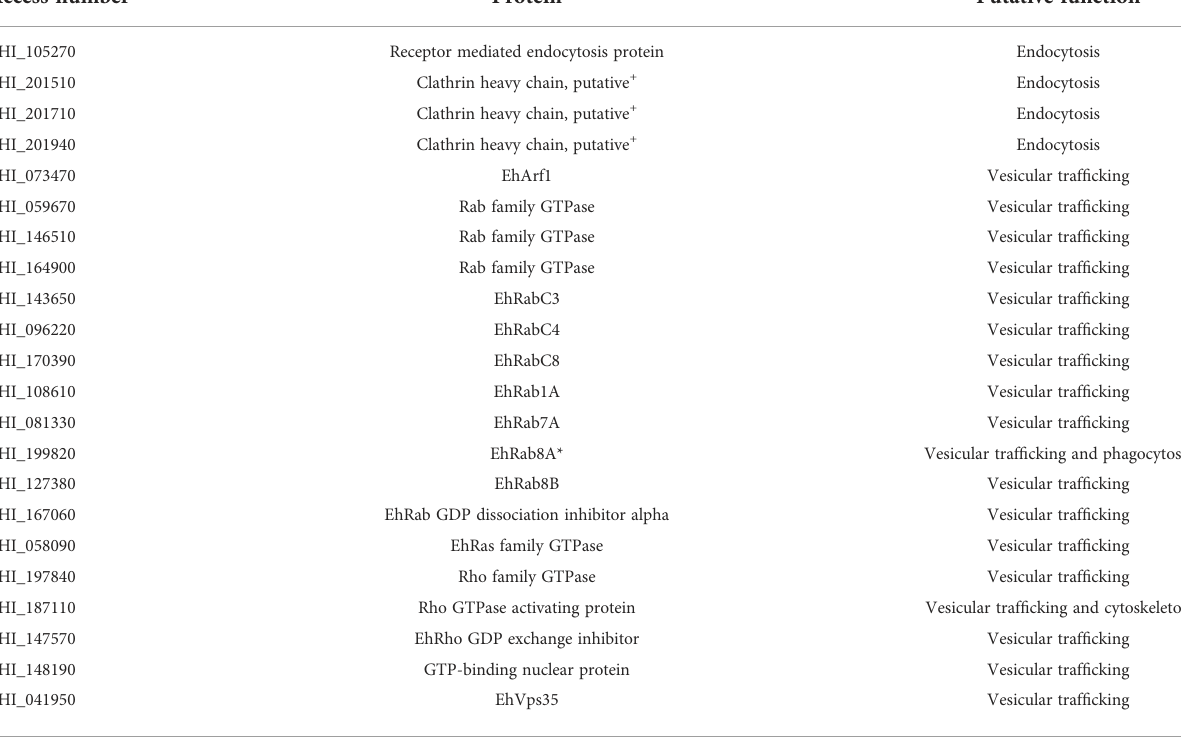
TABLE 2 E. histolytica secreted proteins that associate to LBPA and related to vesicular traf fi cking and cytoskeleton. Access